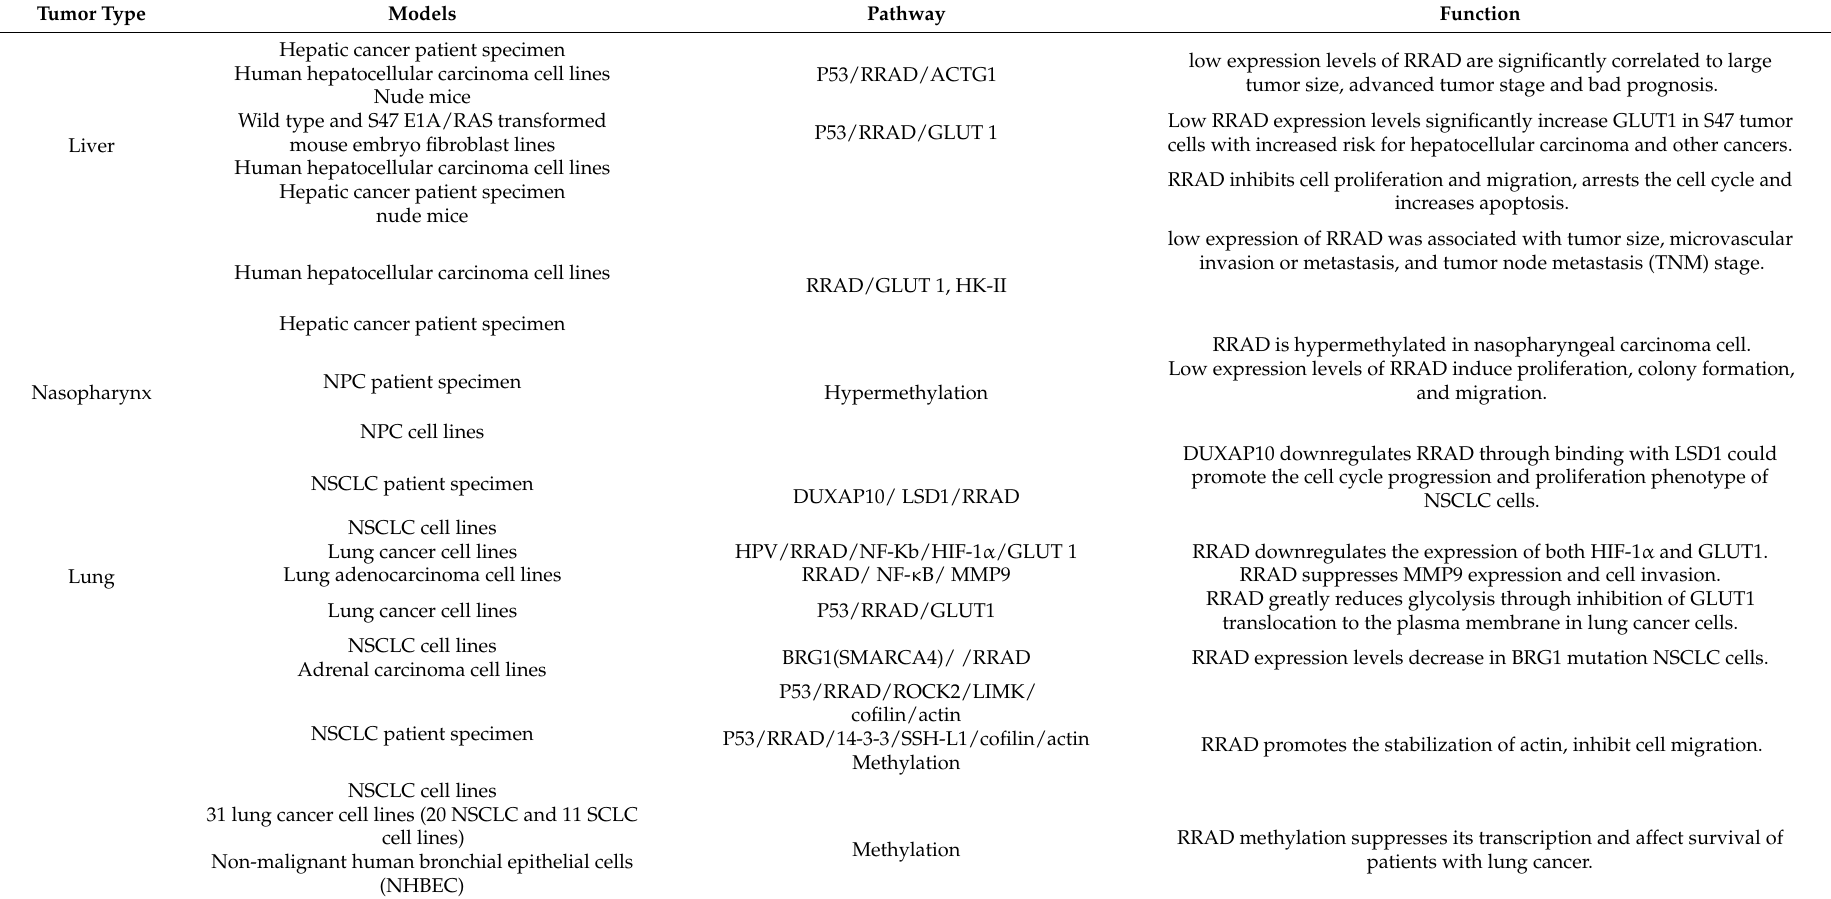
Table 1. Tumor suppressor effect of